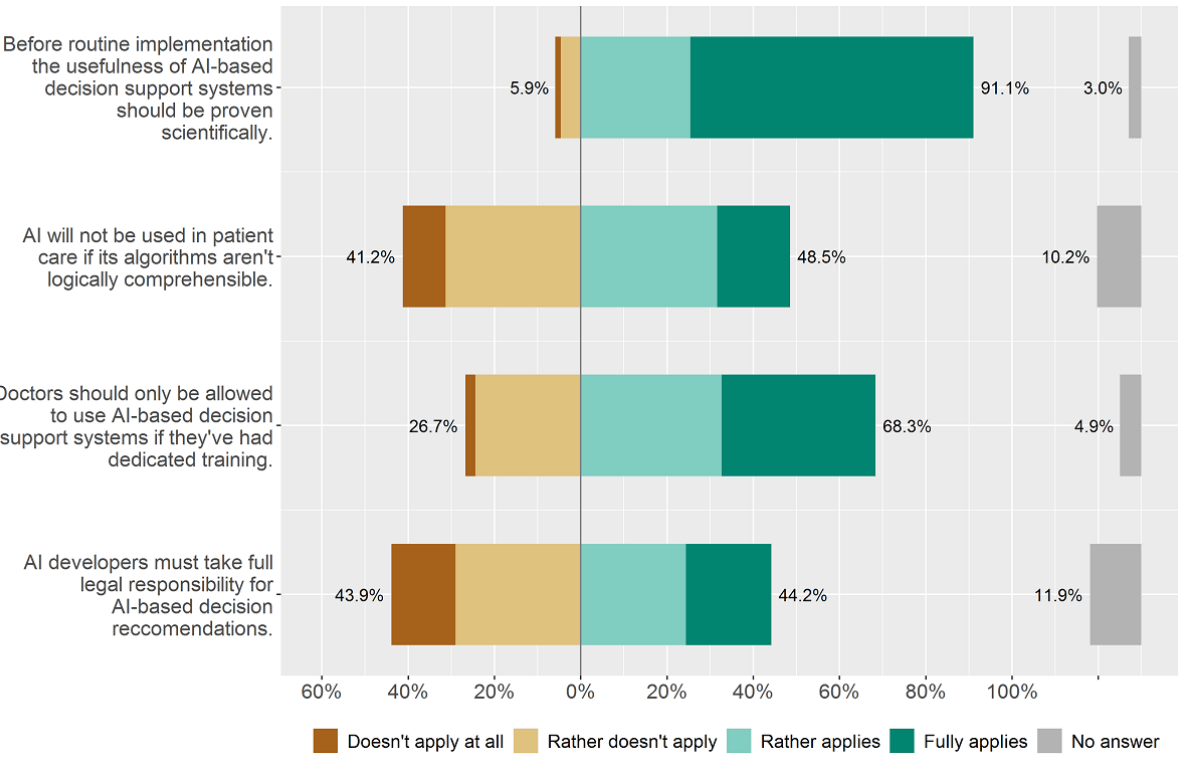
Figure 1. Rules and regulatory requirements of artificial intelligence (AI) usage in